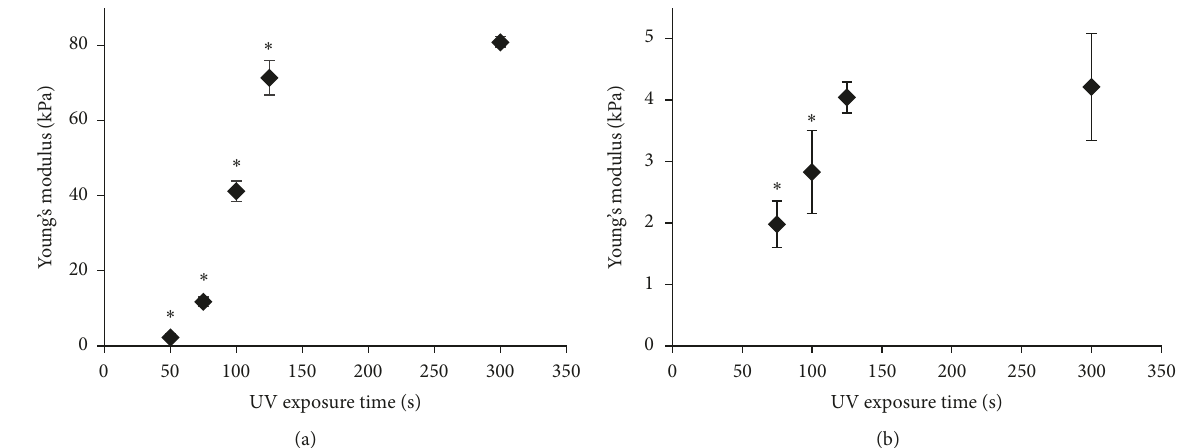
Figure 3: Young’s modulus as a function of UV exposure time for (a) A12-B.25 and (b) A8-B.10, PAA hydrogels. Asterisks designate significant differences from Young’s modulus for gels polymerized at an exposure time of 300s ( 𝑝 < 0.05 , 𝑛 = 3